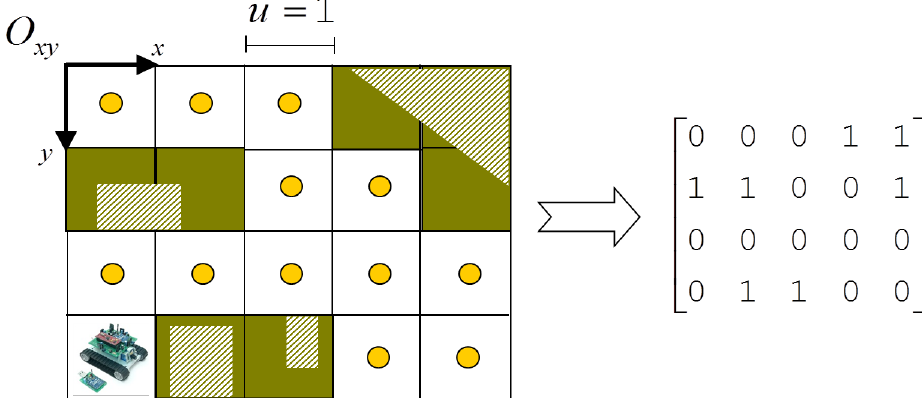
Figure 1. Equivalence between a 2D map and its correspondent binary matrix model. The diagonal-stripes area depicts the real obstacle shapes, whereas the dark tiles are the correspondent obstructed cells. The circles represent all possible coordinates the robot may occupy in the